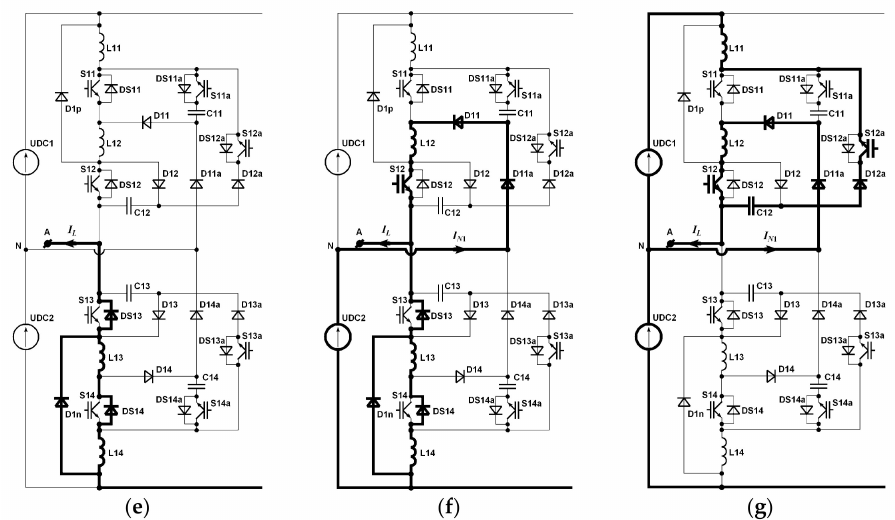
Figure 6. Operation stages when S12 is switched ON/OFF in individual time intervals: ( a ) before time t 21 ; ( b ) t 21 – t 22 ; ( c ) t 22 – t 23 ; ( d ) t 23 – t 24 ; ( e ) t 24 – t 25 ; ( f ) t 25 – t 26 ; ( g ) t 26 – t 27